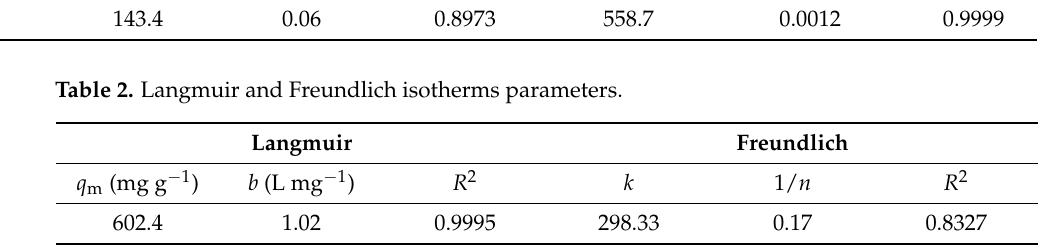
Figure S2: The desorbed MB concentrations in ethanol for five cycles. Table S1: The specific surface area of various porous carbon materials. Table S2: The q m of various adsorbents